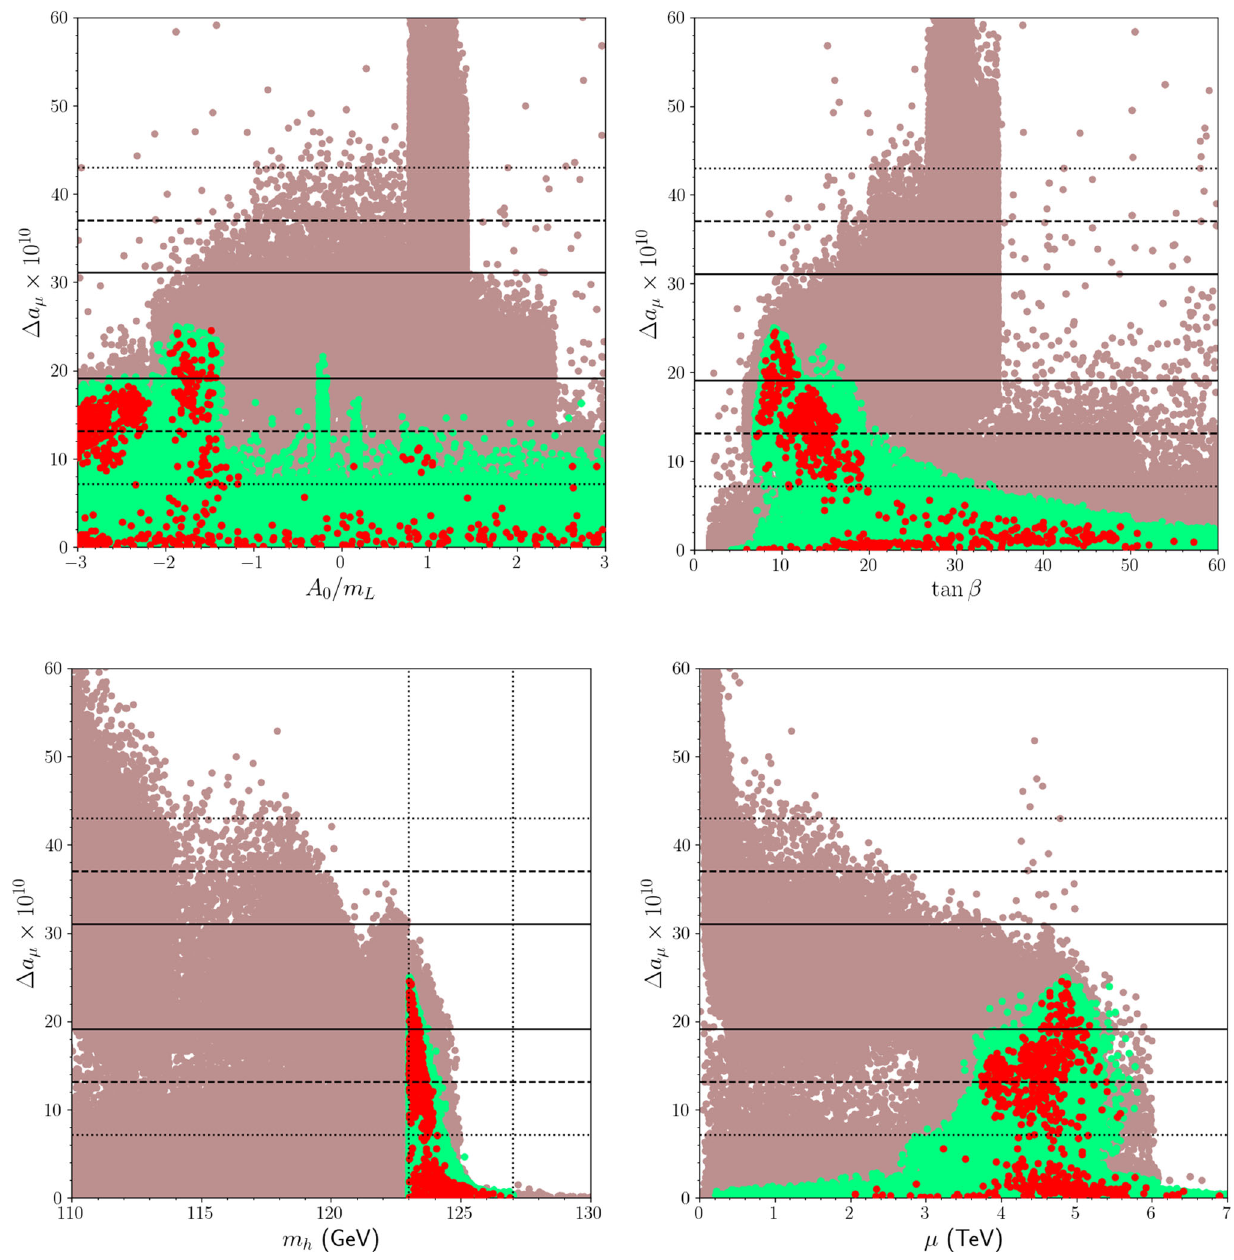
Fig. 4 Plots in the (cid:5) a μ − A 0 / m L , (cid:5) a μ − tan β , (cid:5) a μ − m h and (cid:5) a μ − μ planes. The meanings of colors and horizontal lines are the same as in